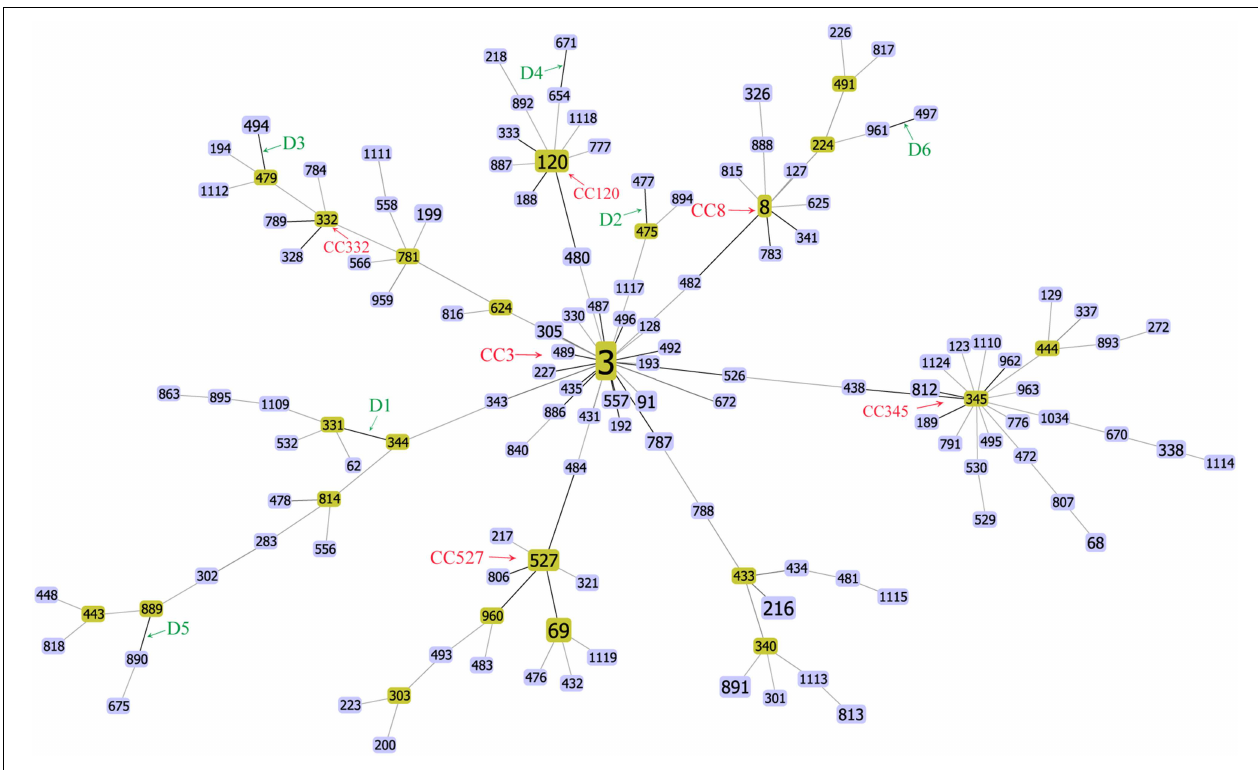
FIGURE 1 | FullMST of V. parahaemolyticus in China based on nucleotide sequence. Six clonal complexes (CC3, CC8, C120, CC332, CC345, and CC527), six doublets (D1–D6), and 91 singletons were